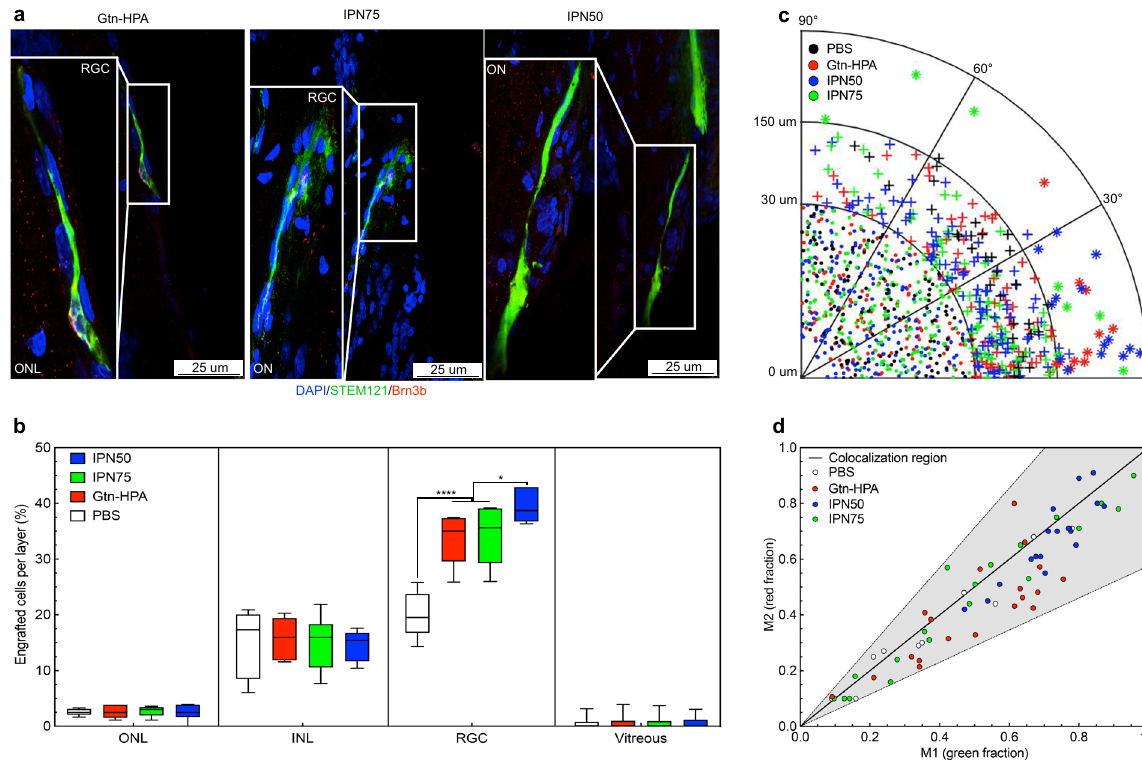
Fig. 4 In vivo vitreal injection of encapsulated human retinal ganglion cells in Long Evans rats. a Fluorescence microscopy images of retina sections 1-month post transplantation. All images were taken at 63X magni fi cation with confocal microscopy (scale bar – 25 um). Slides were stained with DAPI-VioBlue (nuclei staining), STEM121-FITC (human marker), and Brn3b-TdTomato (RGC marker present in all injected cells and some host RGC). Immunohistochemistry shows cell bodies expressing human marker extending processes inside the retina towards the optic nerve, suggesting engraftment, for all samples injected in hydrogels. No such fi ndings were seen cells injected in PBS. b . Statistical analysis, using one-way ANOVA followed by Tukey ’ s test, of the percentage of engrafted hRGC per layer after 1-month. N = 60 fi eld of views were analyzed to localize injected cells in their retinal layer and extrapolate the percentage of engrafted cells. hRGC engraftment percentage was signi fi cantly higher in hydrogels groups compared to PBS (**** p < 0.0001) in the target layer (RGC): IPN50 showing a higher engraftment (high average showed with center line) and narrower distribution (smaller box corresponding to 75% interval and smaller whiskers corresponding to SEM) compared to other hydrogels (* p = 0.01). Cell size and orientation were measured for more than 1×10 3 cells and is shown as a polar plot for all groups in c Cells were divided into three categories: undifferentiated round cells ( r < 30 um), medium-size processes extension (30 < r < 150 um) and long processes extension ( r > 150 um). All long cells were observed only in the hydrogel groups, being parallel to the retina. d Colocalization analysis of cells extended processes. All events were located in the co-localization region, con fi rming the presence of both STEM121 and Brn3b markers in injected